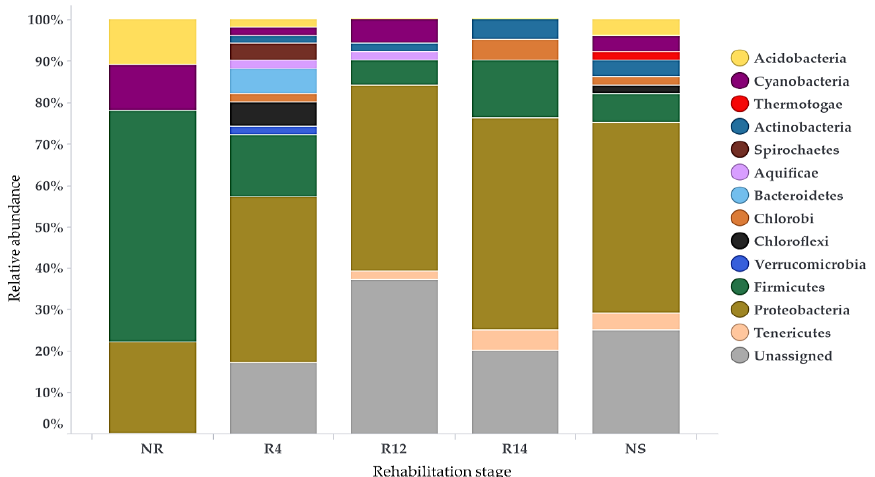
Figure 4. Relative abundance of peptides per phylum of bacteria in soils from each rehabilitation stage. It was built on peptides data obtained from the Unipept 4.0 software.